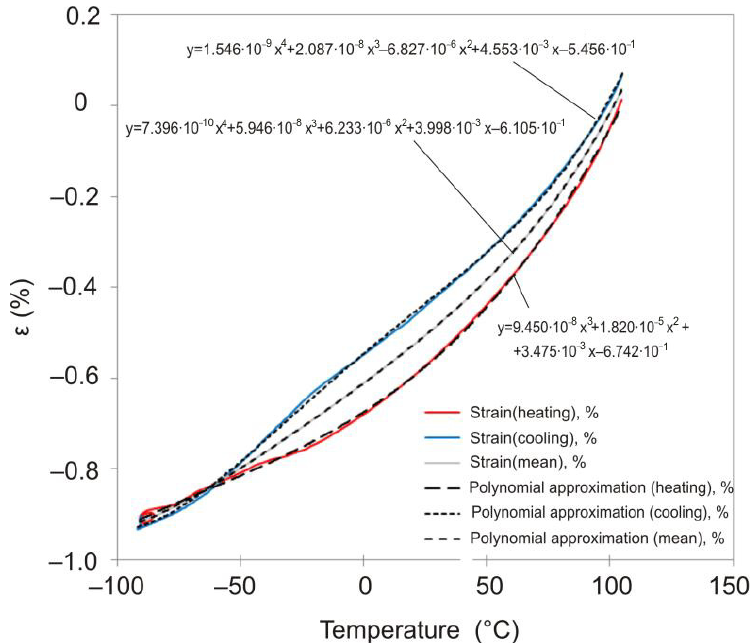
Figure 5. Temperature dependence of strain for EPO-TEK 330 polymer, cooling/heating rate 2 °C/min, sample thickness 245 μ m. Approximations by a power polynomial of the temperature dependence of strain on heating, cooling, and their averaged values.